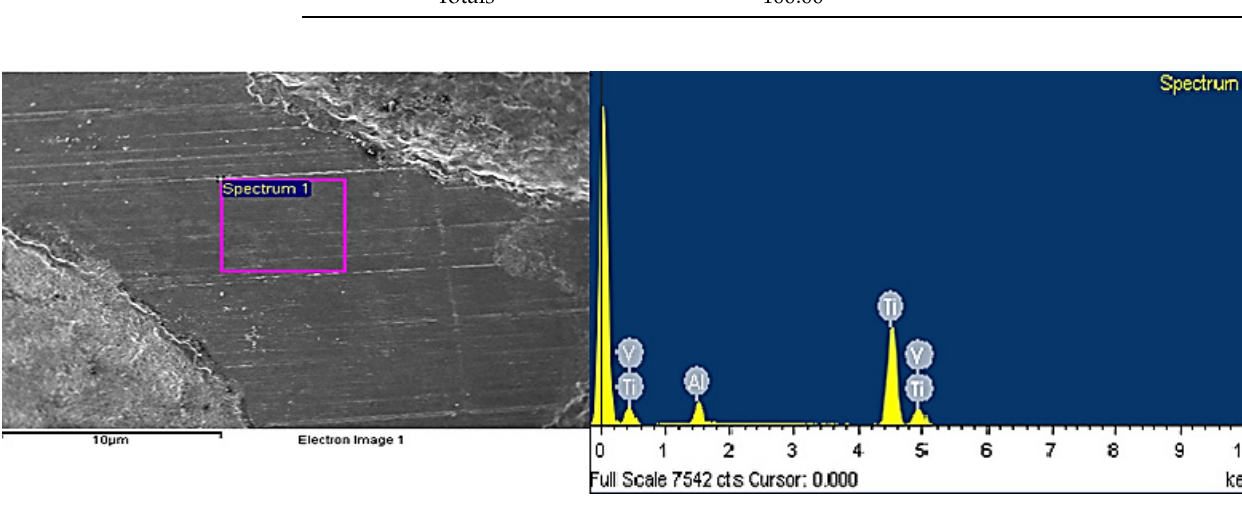
Figure 1. EDS spectra of Ti-6Al-4V .